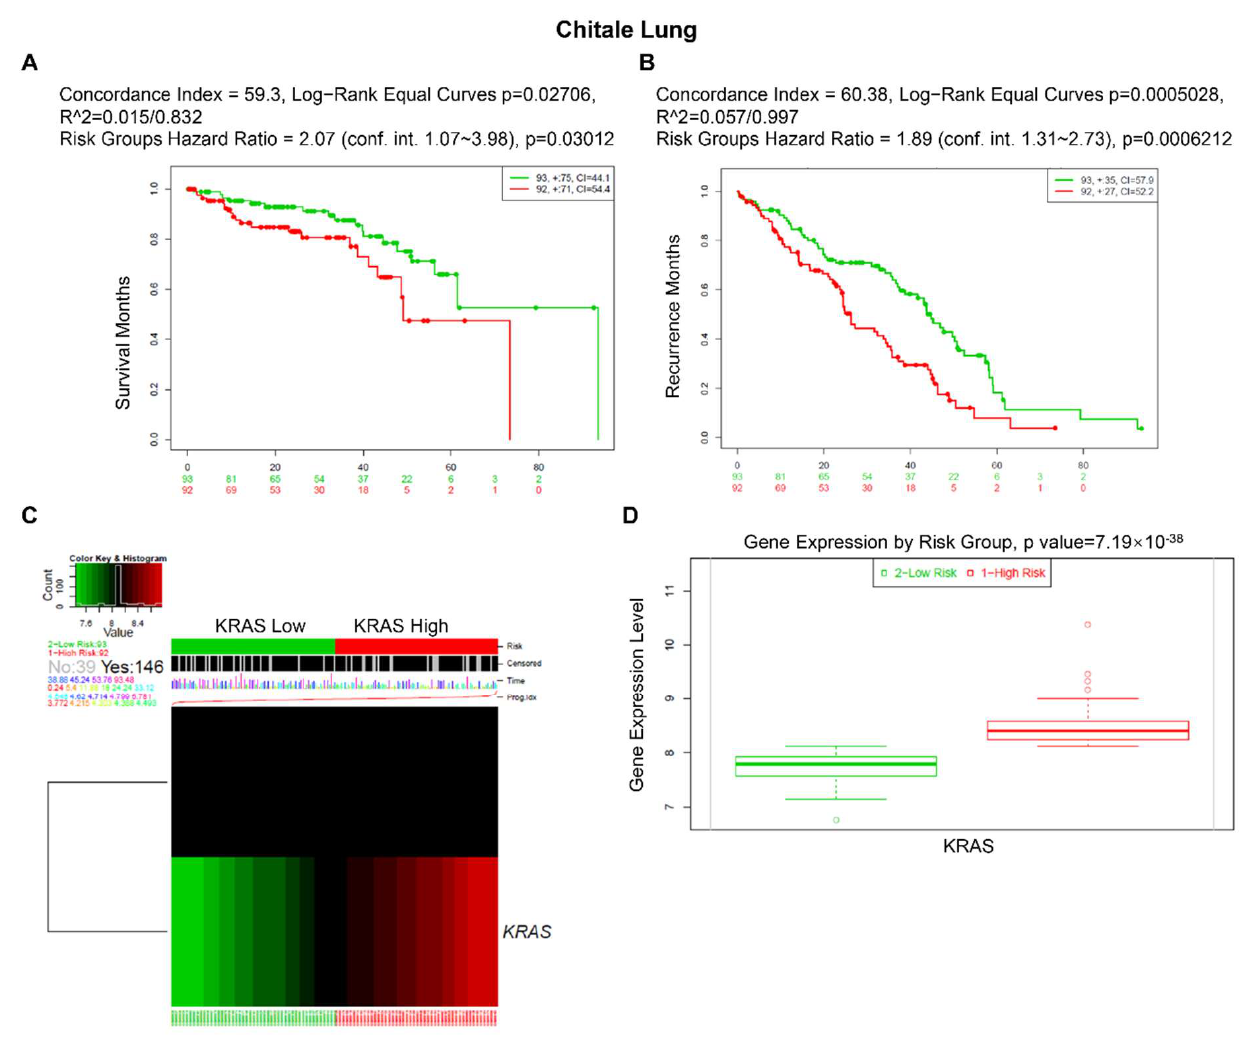
Figure 8. Expression level and prognostic values of KRAS for OS from the training cohorts of lung cancer via SurvExpress Platform. ( A , B ) Kaplan–Meier curves for survival ( A ) and recurrence ( B ) of KRAS between high- and low-risk groups. ( C , D ) Heatmap ( C ) and histogram figure ( D ) showing the KRAS level in high- and low-risk groups. A p -value < 0.05 was considered a significant threshold. Table 5. Drug–gene interactions or potentially available drug categories with abnormal expression of KRAS.